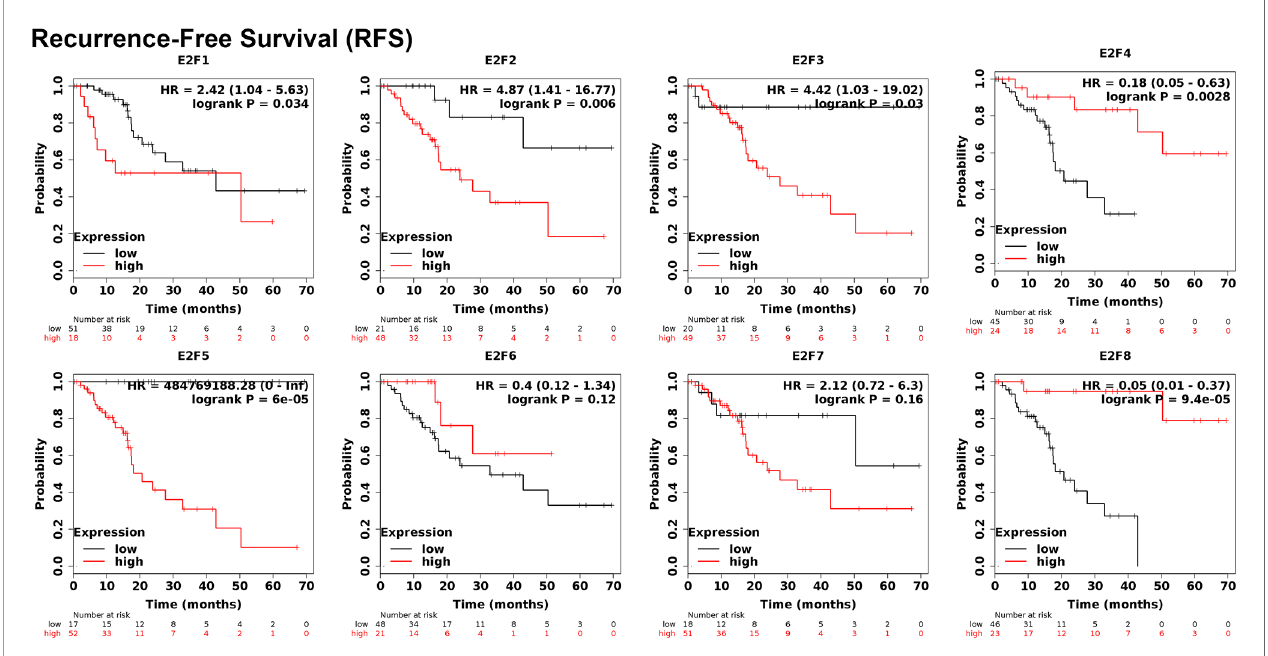
FIGURE 5 | The prognostic value of different expressed E2Fs in PAAD patients in the RFS curve (Kaplan – Meier